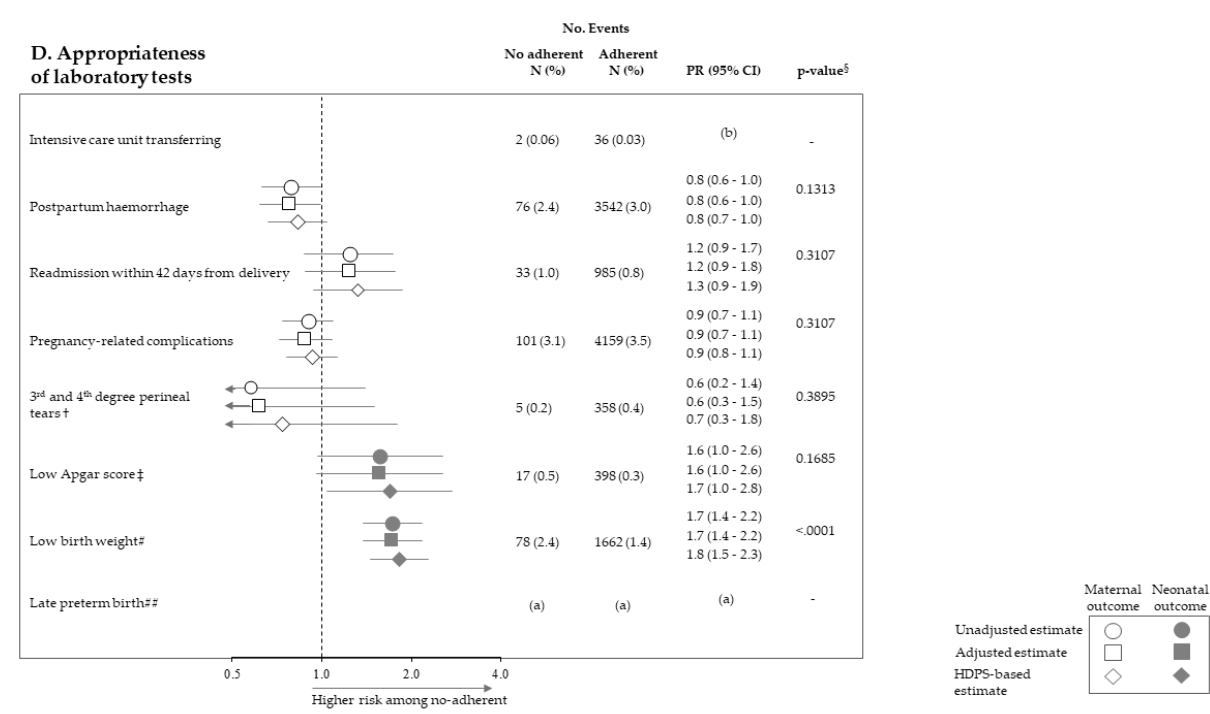
Figure 2. Forest plot picturing the association between exposure to no-adherence with selected recommendations and the risk of maternal or neonatal outcomes. Prevalence ratio (PR) and 95% confidence interval (CI) were estimated with log-binomial regression models. Estimates unadjusted and adjusted for covariates listed in Table 1 are shown. In addition, estimates obtained with high-dimensional propensity score (HDPS) stratification design are displayed. † The 96,837 women who experienced vaginal birth were included into the specific cohort, rather than the 122,563 ones with either vaginal birth or caesarean delivery as for other associations. ‡ Value of the Apgar score at five minutes < 7. # Birth weight < 2500 g. ## Late preterm birth between the 34th and 36th week. The 125,985 women with gestational age ranging from the 34th to the 42nd week were included in the specific cohort, rather than the 122,563 ones with gestational age from the 37th and the 42nd week as for other associations. § p -value adjusted using the Benjamini – Hochberg false discovery rate control procedure. (a) Because women who had shorter pregnancy duration had less time to experience appropriate care, and as this may lead to misclassified immortal person-time, the specific association was not evaluated (see text). (b) As exposure and outcome were both very rareness, the sample size was not sufficient to appreciate a 2.0 minimum detectable PR, and the specific association was then not evaluated (see text).